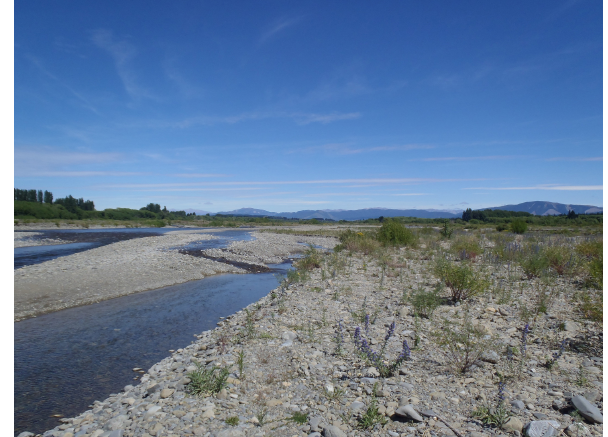
Figure 3. The Rakahuri/Ashley River in New Zealand displaying a typical braided river consisting of multiple channels, gravel bars and vegetated islands. Photo: Katie